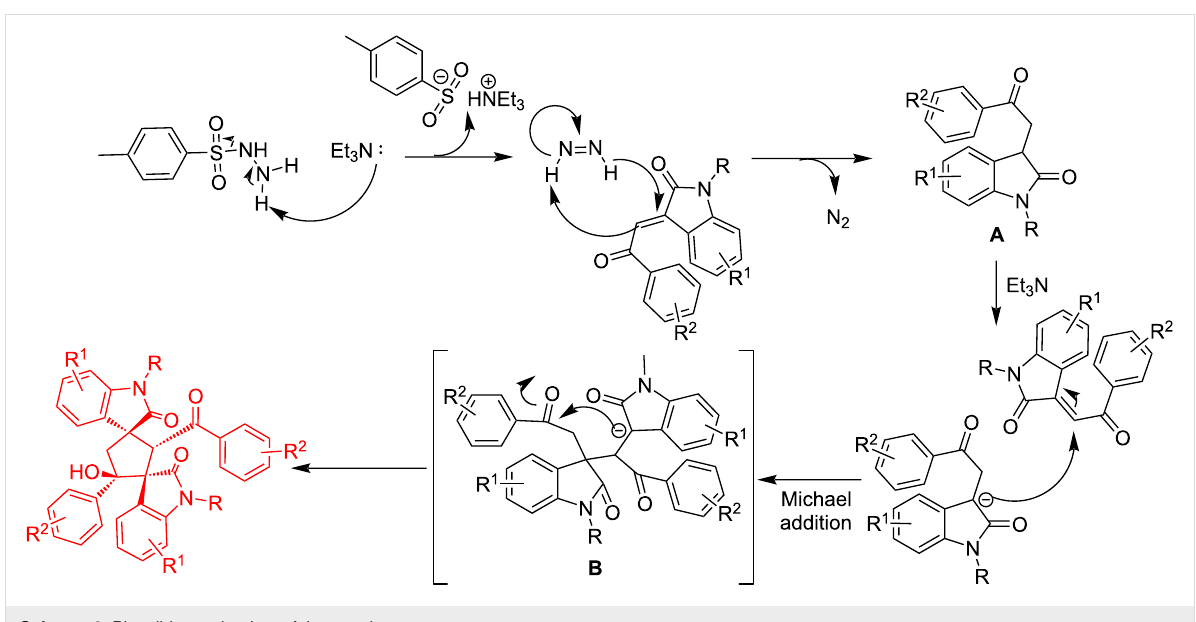
Scheme 4: Plausible mechanism of the